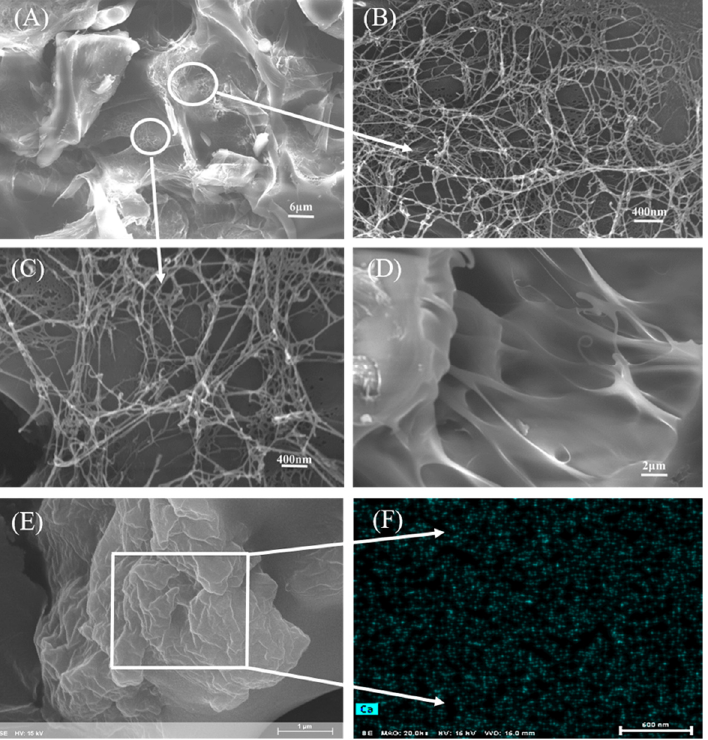
Figure 6. SEM images of the freeze-dried CAAMC surface ( A ), magnified small holes on the CAAMC network wall ( B , C ), CAAMC cross-sectional view ( D ), normal drying CAAMC surface ( E ), and the corresponding EDS Ca element mapping of the CAAMC ( F ).